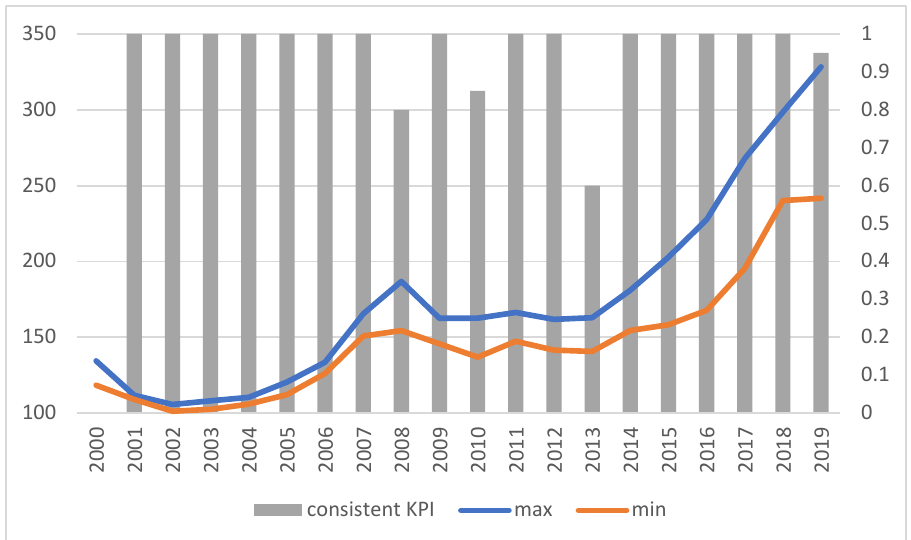
Figure 7. The range of indicator values (left axis) and consistency of results (right axis) for 𝐾𝑃𝐼 𝑤𝑜𝑟𝑠𝑡𝐸 . “ Consistent KPIs ”— KPIs showing the same direction of change compared to the previous year. Source: authors’ own material based on the GUS data. The differences between the maximum and minimum average KPIs, measured by medians, do not exceed 13%. The smallest differences in KPI values between approaches using BD and K ranks occur for weights determined by the RE method (with parameter p = 3.5), and the smallest for the case not accounting for weights (Table 8). The differences in median levels are not statistically significant for a significance level of 0.05. Table 8. Medians of economic KPI ( 𝐾𝑃𝐼 𝑤𝑜𝑟𝑠𝑡𝐸 ) determined by methods K and BD.